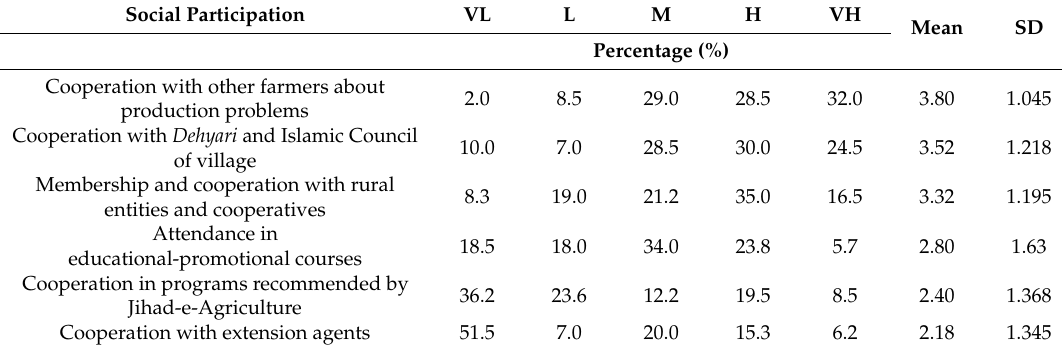
Table 4. Social participation of rice growers in Rudsar County ( n = 400).